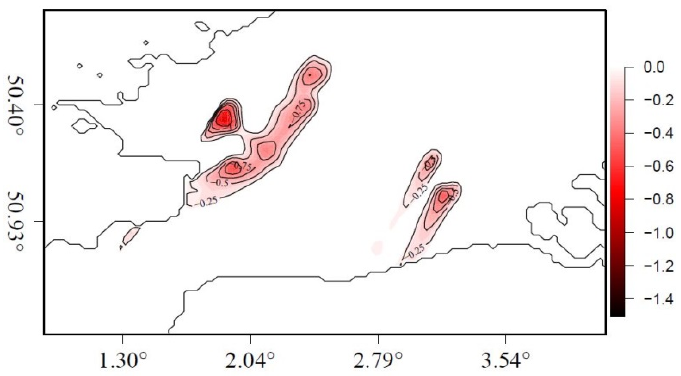
Figure 3. WRF wake model results on velocity deficit in m·s − 1 at 10 m AMSL at 30 April 2013 at 18:00 UTC at the wind farms London Array, Greater Gabbard, Thanet, Belwind 1 and Thornton